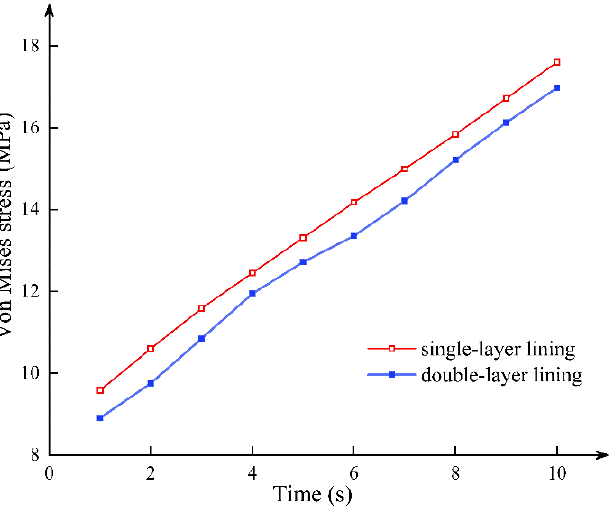
Figure 5. Stress–time curve of single-layer lining and double-layer lining at a node around the concrete compression area.